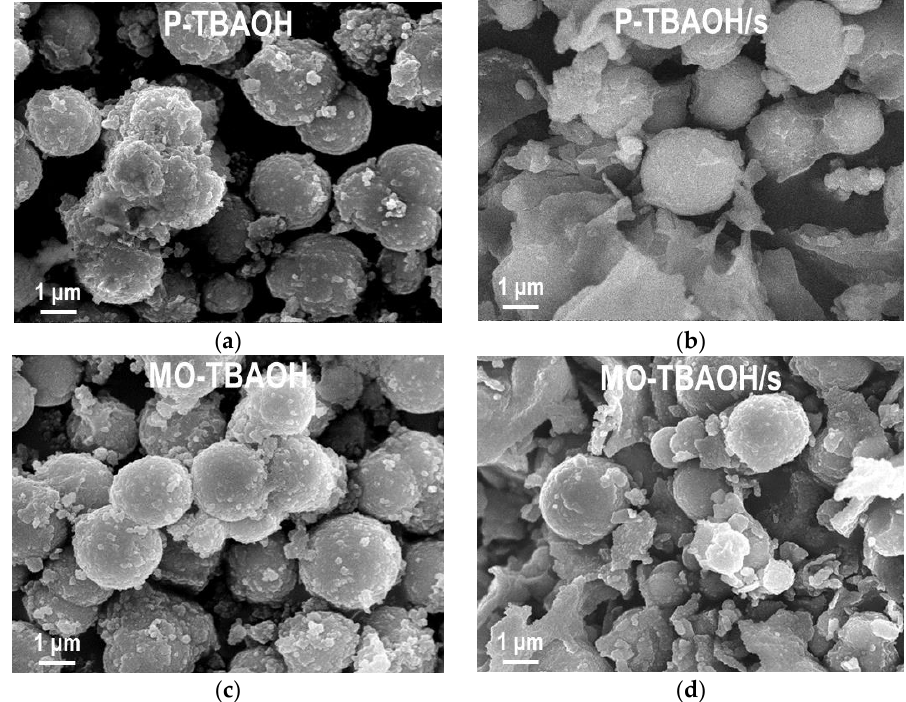
Figure 3. SEM images of precursors and calcined mixed-oxide materials obtained with TBAOH pre- cipitant, without or with starch: ( a ) P-TBAOH; ( b ) P-TBAOH/s; ( c ) MO-TBAOH; ( d ) MO-TBAOH/s. Magnification × 10,000.